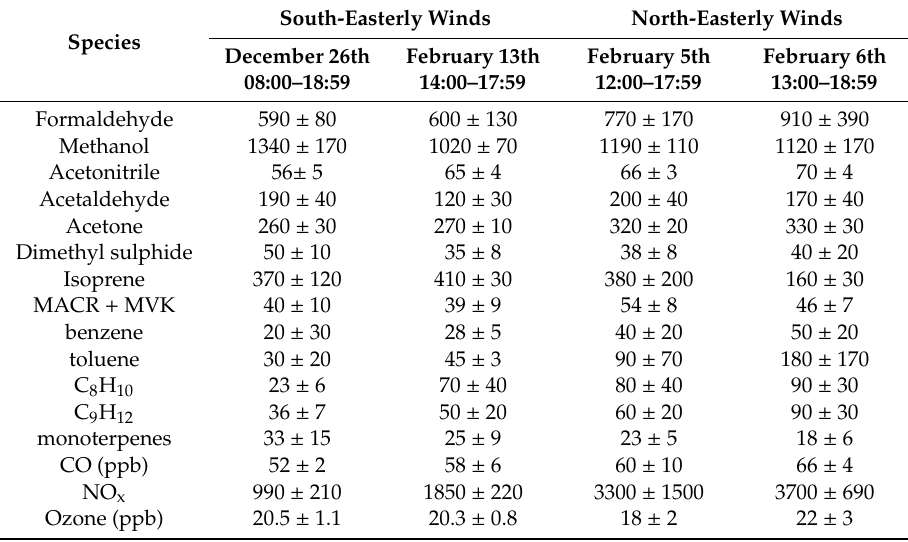
Figure A1. Pre-calculated back-trajectories are available for Wollongong every three hours through the R package openair [94]. These trajectories are calculated using HYSPLIT (Hybrid Single Particle Lagrangian Integrated Trajectory Model) [95] from a height of 10 m and propagated backwards in time for 96 h. This figure shows the 96-h back-trajectories whose arrival times coincided with periods of low radon ( < 200 mBq / m 3 ), coloured by the wind direction observed in Wollongong at the time of arrival. Arrival times are 09:00, 12:00, 15:00 and 18:00 AEST on 26 December 2012, 12:00 and 15:00 AEST on 5 February 2013, 12:00, 15:00 and 18:00 on 6 February 2012 and 15:00 AEST on 13 February 2013. Table A1. Mean mole fractions for thirteen VOC species, CO, NO x and ozone, observed over periods during which marine air reached the MUMBA site. The standard deviation is provided to illustrate variability in the mole fractions over those periods and does not reflect measurement error. All mole fractions are in ppt unless otherwise